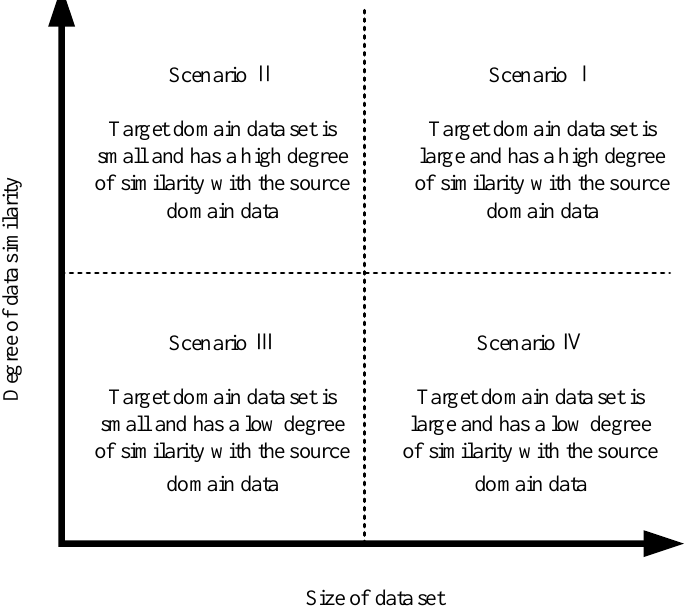
Figure 1. Deep learning PHM algorithm transfer scenario map.